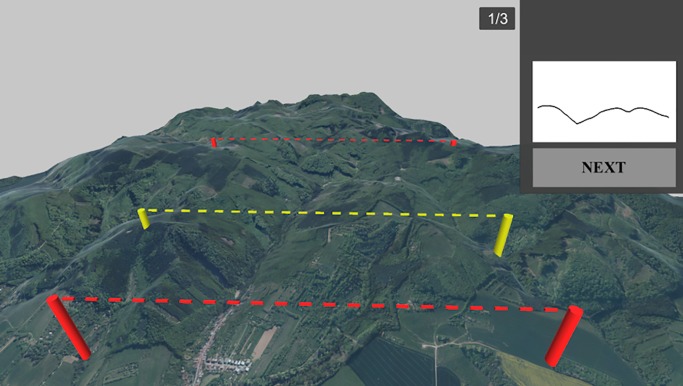
Example of Task 3 –Terrain profiles.Yellow indicates that the profile was selected by the participant. Adapted from [61] under a CC BY license, with permission from [ČÚZK], original copyright [2018/2019].